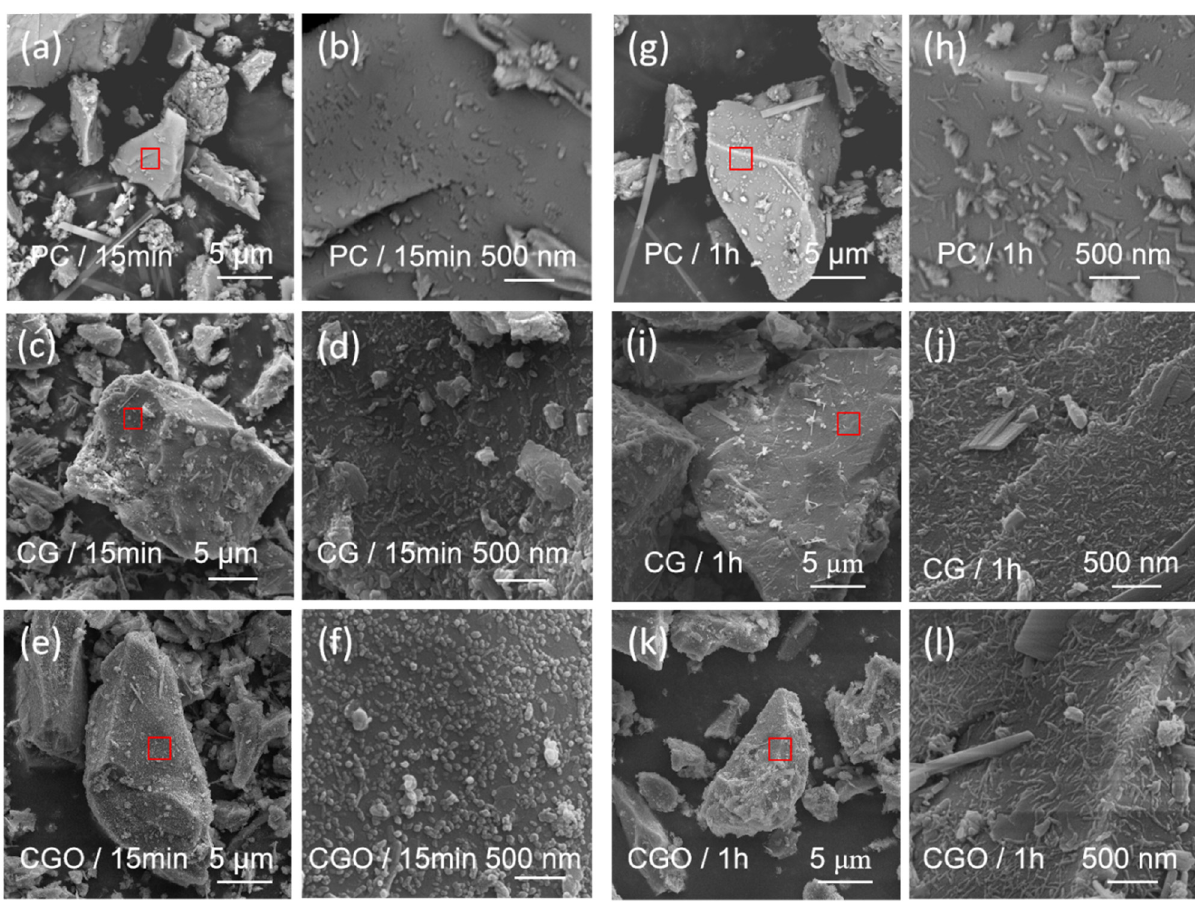
Figure 3: Morphology of hydration products on the surface of cement particles at 15 min in PC ( a and b ) , CG ( c and d ) , CGO ( e and f ) , and at 1 h in PC ( g and h ) , CG ( i and j ) , CGO ( k and l )